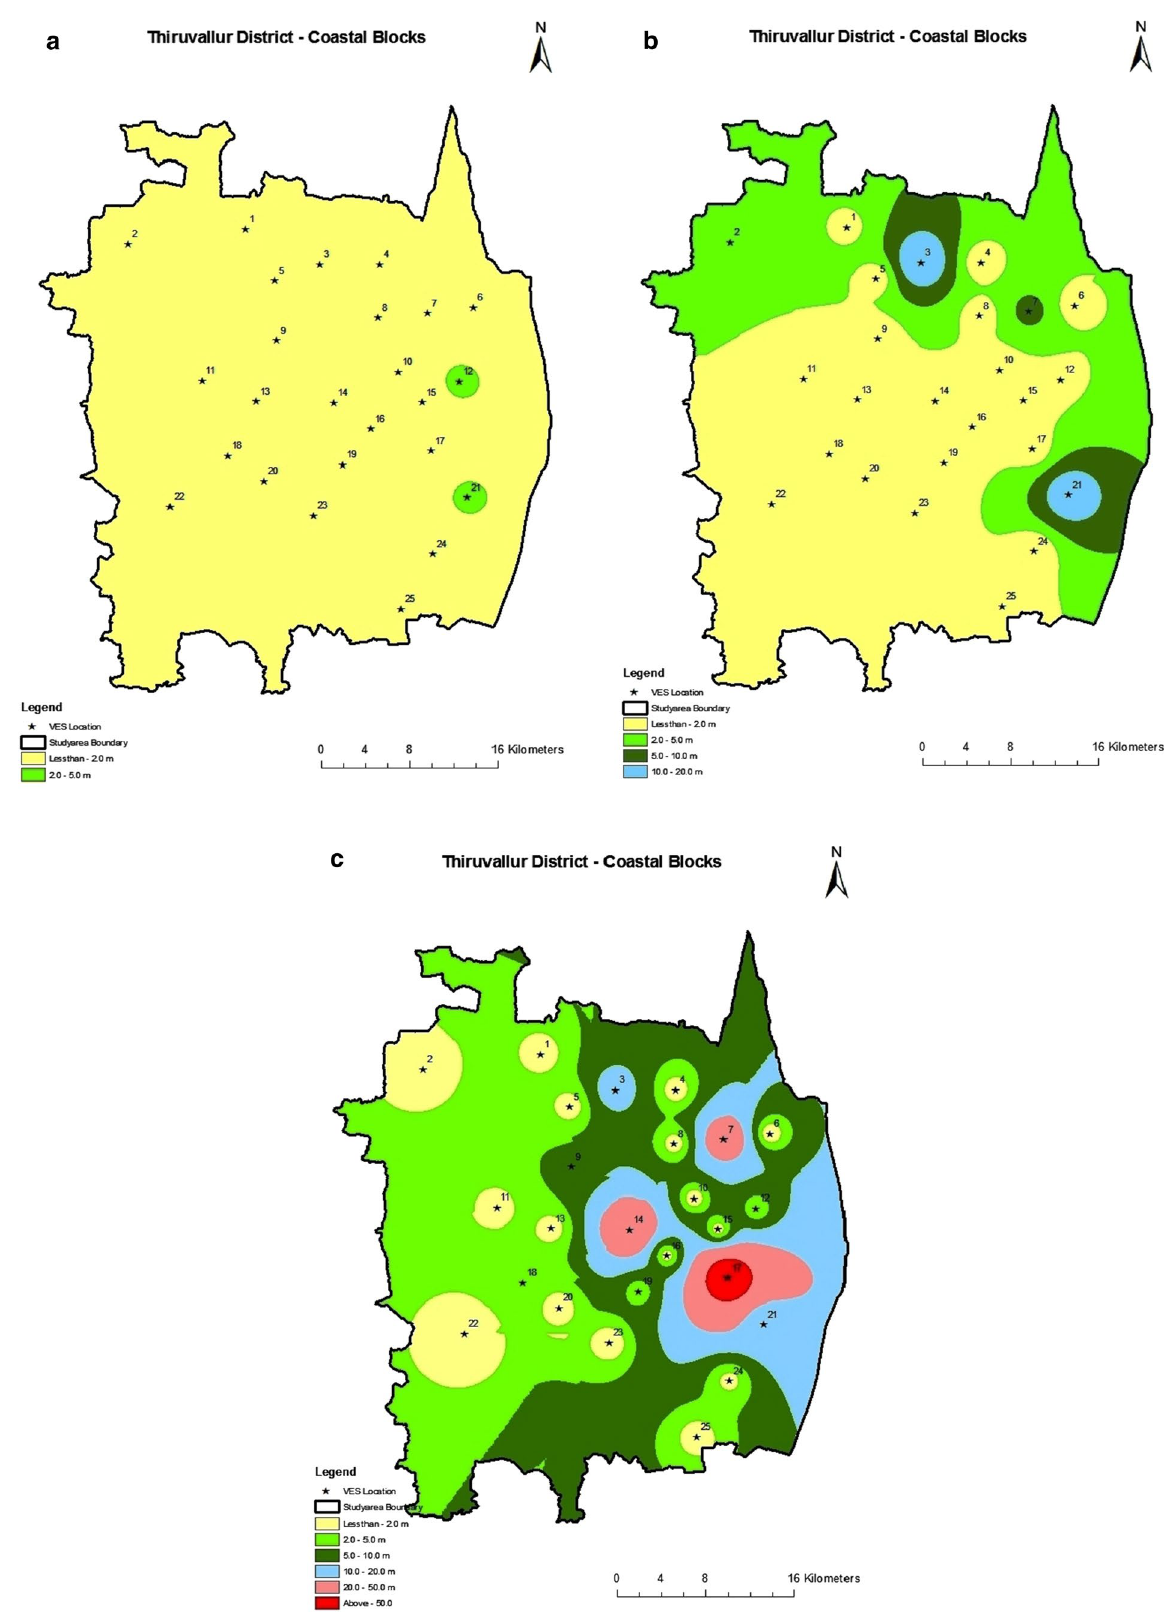
Fig. 11 a First-layer thickness in meter. b Second-layer thickness in meter. c Third-layer thickness in